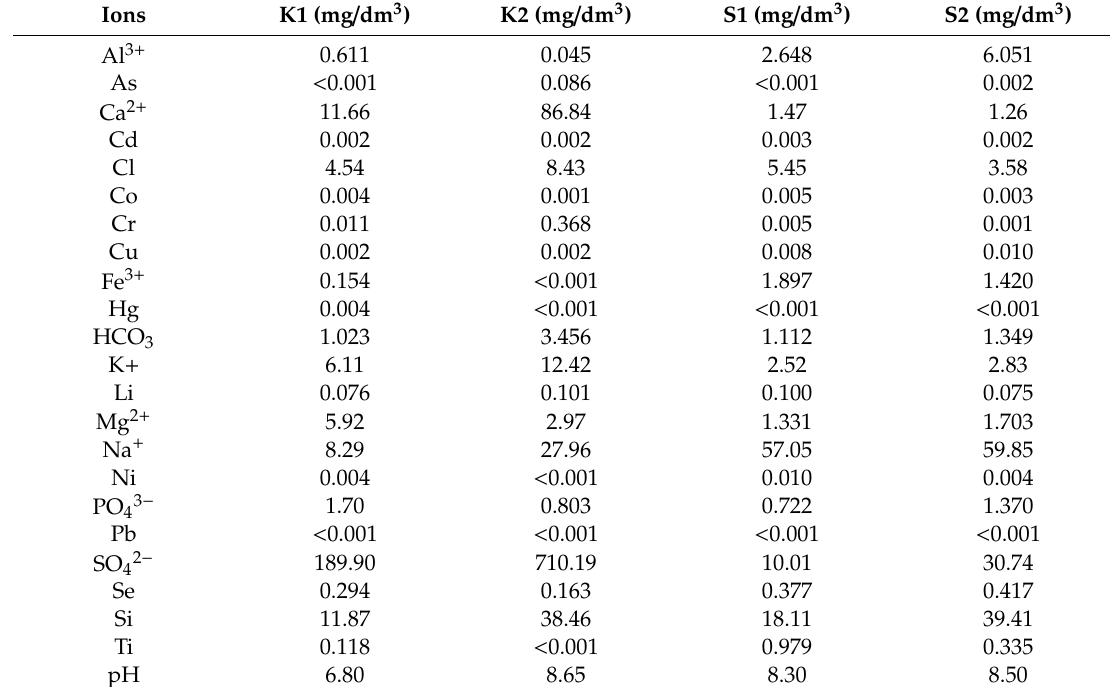
Table 3. The water leaching of ions and the pH of the samples after the calcination process: K1 and K2, and their synthesis: S1 and S2.